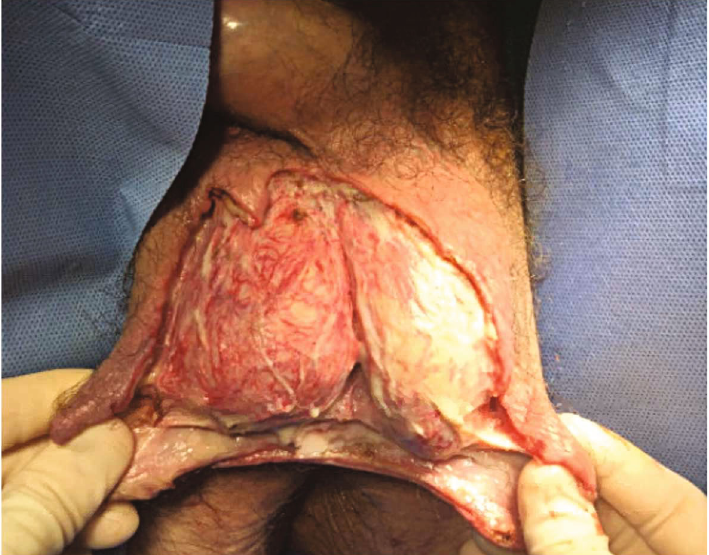
Figure 1: Scrotal wall wound measurement 12 cm ð width Þ × 11cm (length). Right base of penis wound measuring 3 cm ð width Þ × 4cm ð length Þ × 3 cm (depth). Intraoperative during debridement.